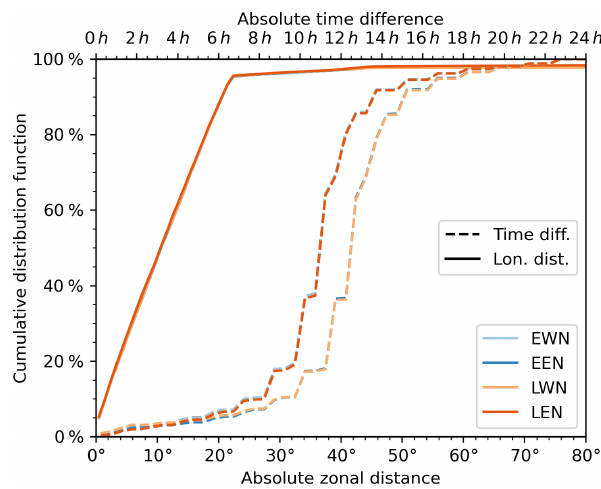
Figure 4. Spatial and temporal distance between Aeolus measure- ment location and the corresponding four nearest neighbours EWN, EWN, LWN, and LEN for all available data from January